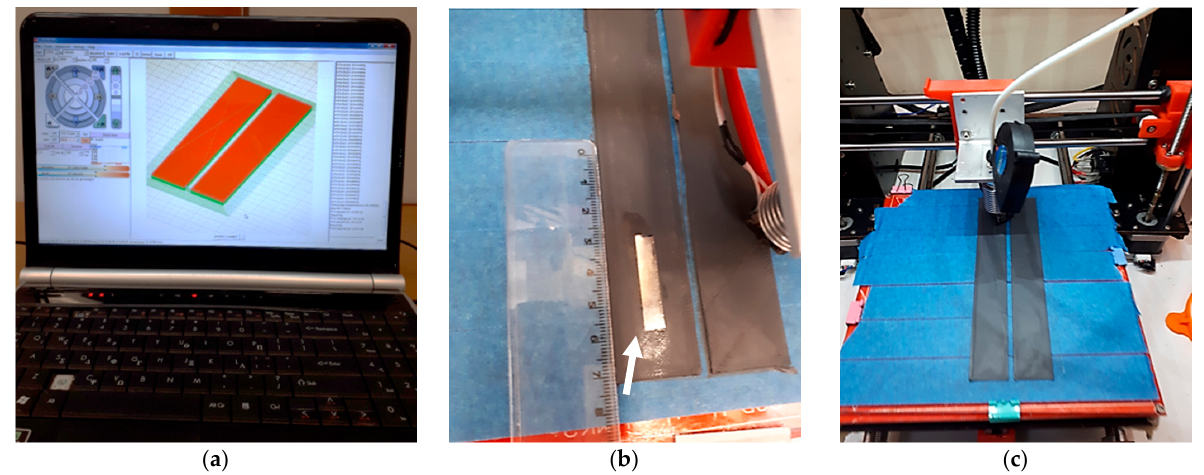
Figure 1. ( a ) Detail of the 3D design file used with Pronterface ® software, which drives the 3D printing process in fused deposition modelling mode; ( b ) Fixing of the Metglas ® strip (indicated by white arrow) via epoxy adhesive whilst 3D printing is temporarily halted (slab is 1.75 mm thick at that point); ( c ) continuation of material layering until a slab thickness of 3 mm is reached.